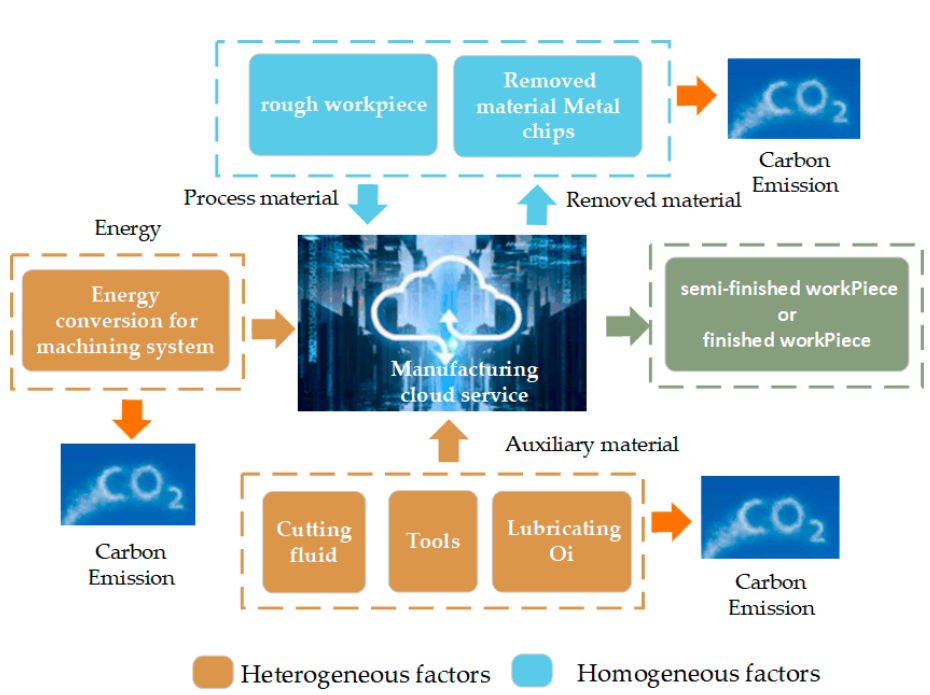
Figure 2. Carbon emission during production.